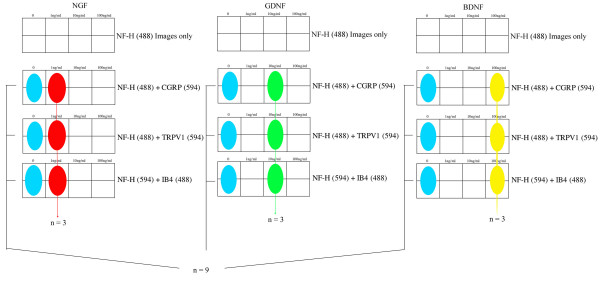
Experimental design for neuronal counting. 12 slides were utilized in these experiments, with 4 slides for each growth factor. The antibodies used on each slide are shown to the right of the slide along with the wavelength for the corresponding secondary antibody. For the 2 matching wells for each slide (growth factor concentration), the neuron numbers were averaged to give one observation (since the wells were not derived from independent cultures). Each slide contained a no growth factor control (blue), hence n = 9 for this condition. All other growth factors at 1 (i.e. NGF, red), 10 (i.e. GDNF, green) or 100 ng/ml (i.e. BDNF, yellow) are n = 3. The same slides were then utilized to ascertain the proportions of neurons expressing CGRP- or TRPV1-immunoreactivity or IB4-binding, as described in Methods. This figure refers to Figures 2 and 3 and Table 1.